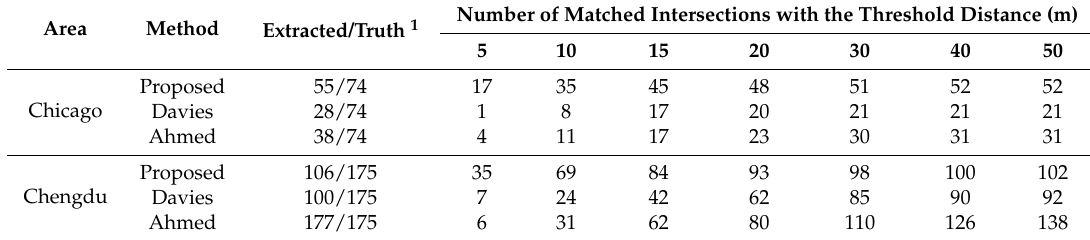
1 Extracted represents the number of intersections that are extracted, and Truth represents the number of real intersections.